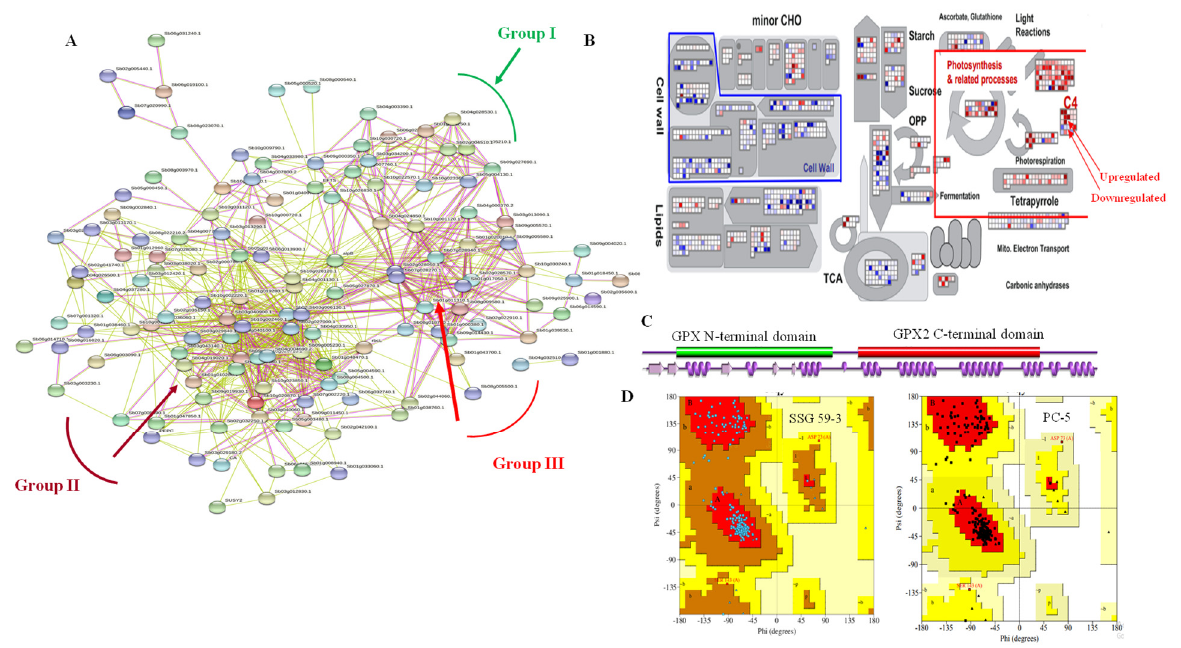
Figure 15. Network analysis: ( A ) STRING-based interaction network analysis of DEGs, ( B ) MapMan pathway analysis, ( C ) 3- D structure of glutathione peroxidase gene using PDBsum, ( D ) Ramachandran plot of amino acid residues in salt- tolerant and susceptible genotype.